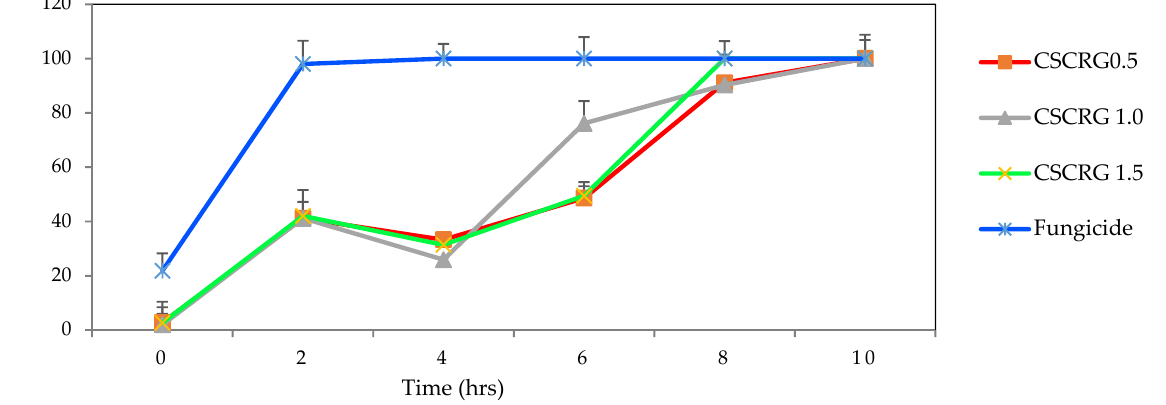
Figure 8. In vitro release behavior showing the slow and sustained release of mancozeb from Chitosan-Carrageenan (CSCRG) conjugated nanoparticles in phosphate-buffered saline (pH 7.2).